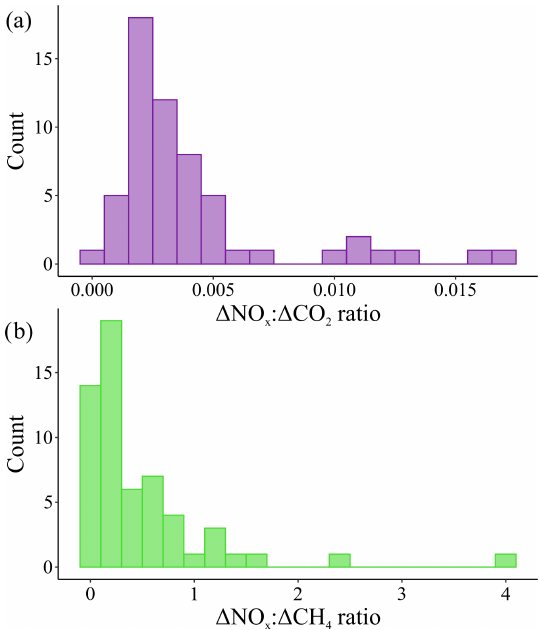
Figure 6. (a) Histogram distribution of destruction removal effi- ciencies (DREs) calculated for CH 4 (blue) and for C 2 H 6 (green). (b) Comparison of DREs for CH 4 and C 2 H 6 . The black dashed line shows a 1 : 1 ratio. The median fuel composition (CH 4 = 0 . 845, C 2 H 6 = 0 . 085) was used for plumes emitted from platforms for which no fuel composition data were available (black triangles).